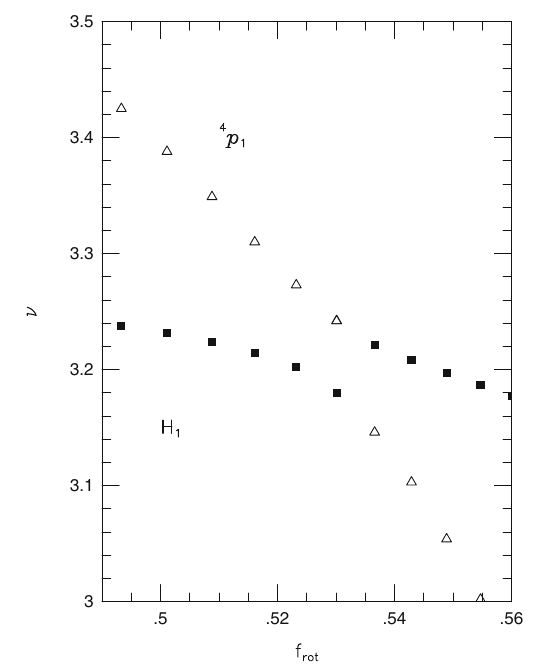
Fig.10 Apparentintersection(duetoavoidedcrossing)oftheaxisymmetricfirstquasi-radialovertone( H 1 ) and the first overtone of the l = 4 p -mode (in the Cowling approximation). Frequencies are normalized √ ρ c / 4 π , where ρ c is the central energy density of the star. The rotational frequency f rot at the mass- by shedding limit is 0 . 597 (in the above units). Along continuous sequences of computed frequencies, mode eigenfunctions are exchanged at the avoided crossing. Defining quasi-normal mode sequences by the shape of their eigenfunction, the H 1 sequence (filled boxes) appears to intersect with the 4 p 1 sequence (triangle), but each sequence shows a discontinuity, when the region of apparent intersection is well resolved. In the notation l mode n ,thesuperscriptindicatesthe l oftheperturbation,whilethesubscriptindicatestheharmonic overtone. (Image reproduced with permission from Yoshida and Eriguchi 2001, copyright by RAS) the 2D numerical evolution scheme). As in Yoshida and Eriguchi (2001), Font et